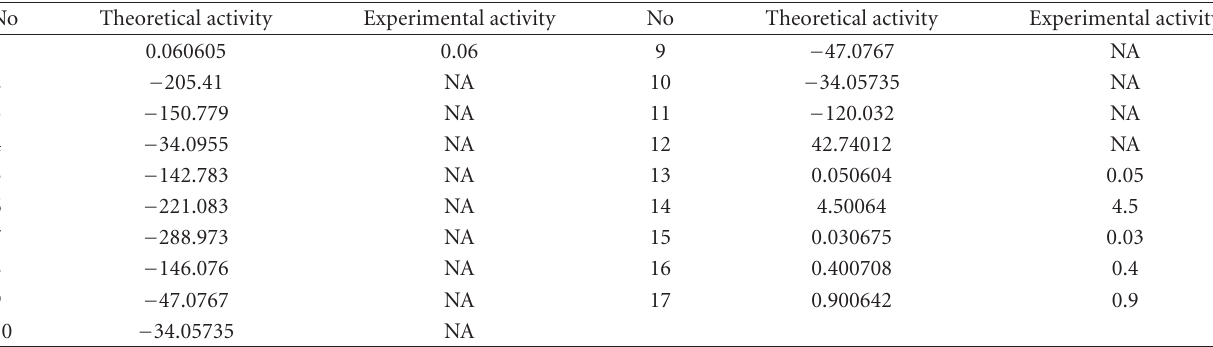
Table 3: Comparison of experimental and theoretical the activity by using the multiple regression analysis for compounds in Skeleton I. No